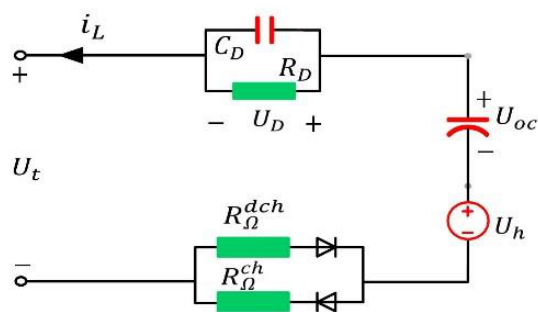
Figure 3. The first-order ECM managing charging and discharging with different internal resistors.